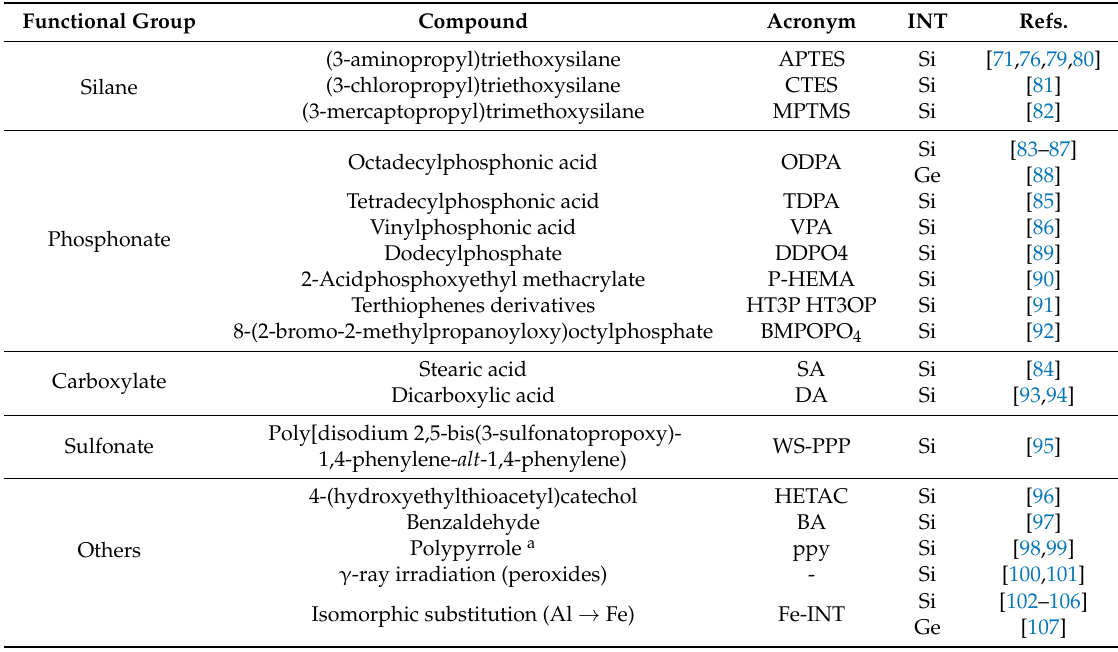
Table 2. Main functionalization routes of the outer wall of imogolite nanotube (INT). Functional